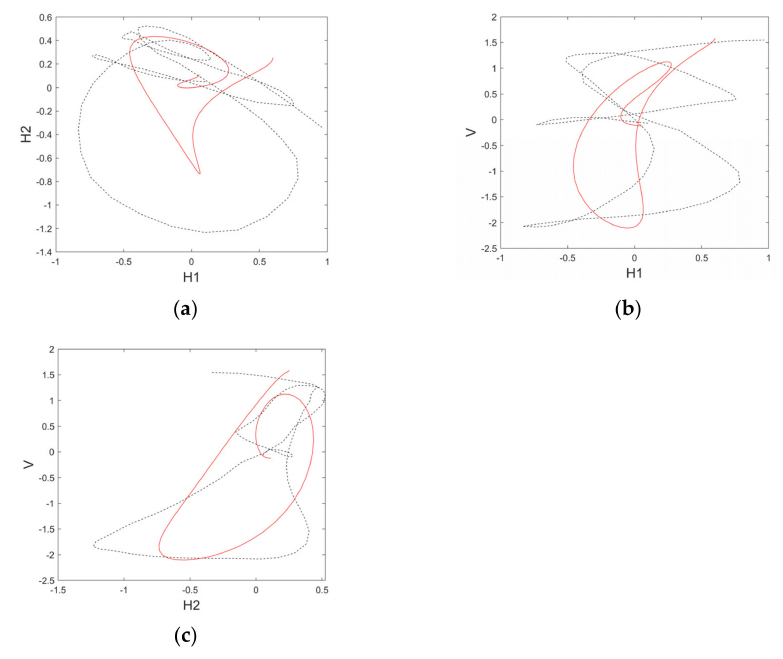
Figure 10. The hodograms of microseismic event data after denoising using VMD. The black dotted lines represent the polarization characterization before denoising, and the red solid lines represent the polarization characterization after denoising. ( a ) The horizontal component H1 vs. horizontal component H2 hodogram. ( b ) The horizontal component H1 vs. vertical component V hodogram. ( c ) The horizontal component H2 vs. vertical component V hodogram.